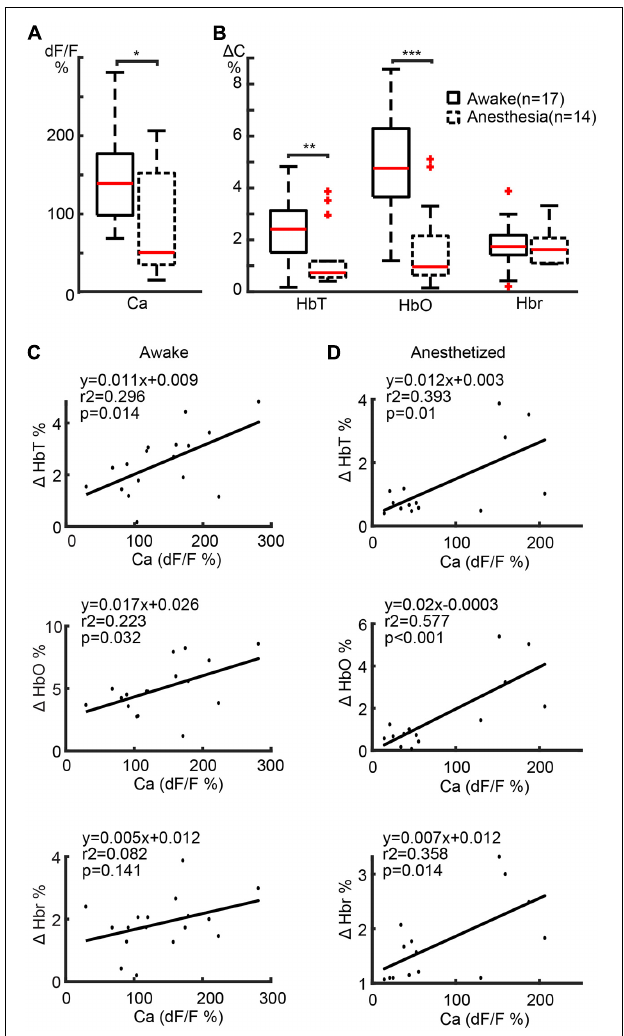
FIGURE 3 | Amplitude correlation between calcium and hemodynamic signals in ipsilateral cortex. (A) Boxplot of maximal calcium amplitude in awake and anesthetized mice. (B) Box plot of maximal hemodynamic amplitude in awake and anesthetized mice. *** p < 0.001, ** p < 0.01, and * p < 0.05. (C,D) Linear regression of maximal calcium and hemodynamic amplitude in awake and anesthetized mice, respectively. The regression equations, r 2 , and p -values are labeled in the